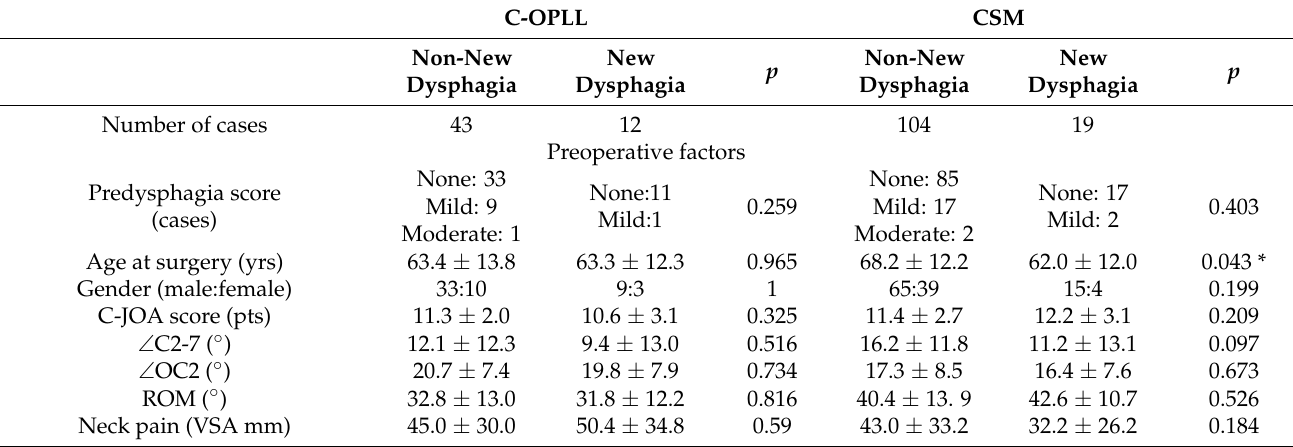
Table 6. Preoperative and surgical factors in the new dysphagia and non-new dysphagia groups —comparative